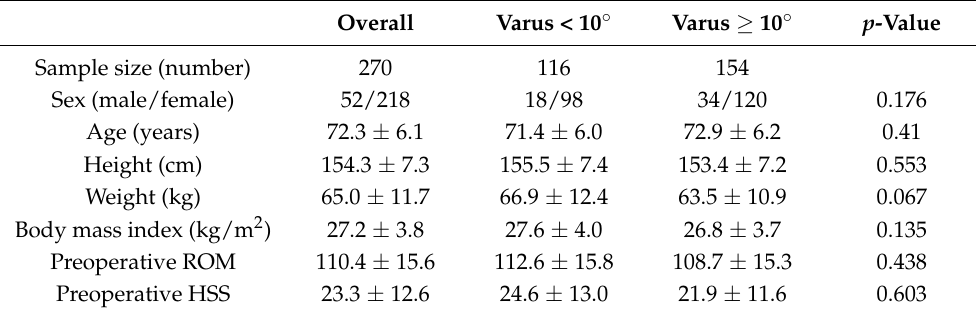
Table 1. Demographic characteristics of subjects classified as severe varus deformity group (hip–knee–ankle [HKA] varus angle ≥ 10 ◦ ) and mild varus deformity group (HKA varus angle < 10 ◦ ). Overall Varus < 10 ◦ Varus ≥ 10 ◦ Sample size (number)